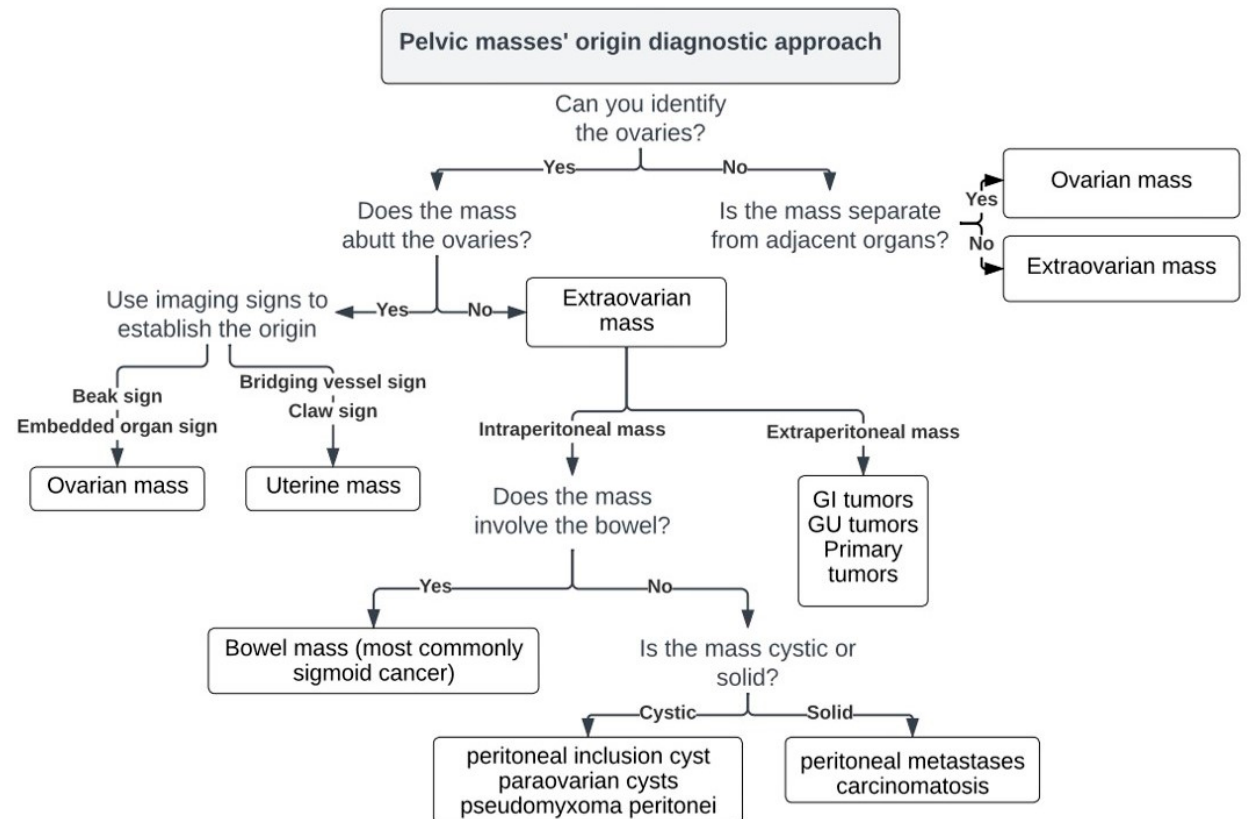
Figure 1. Imaging approach of pelvic masses’ origin.